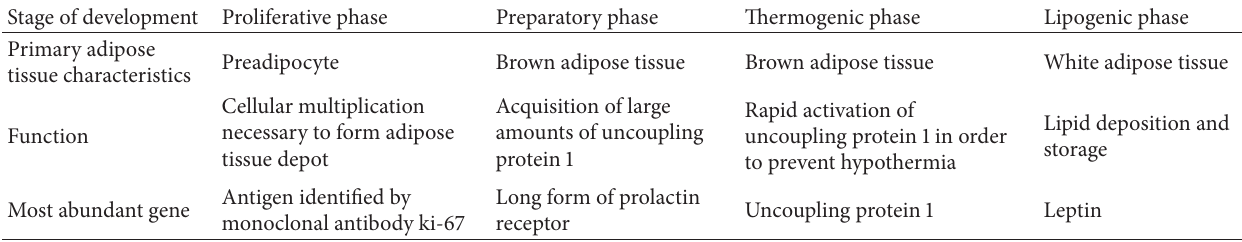
Table 1: Summary of the main developmental changes in adipose tissue during early